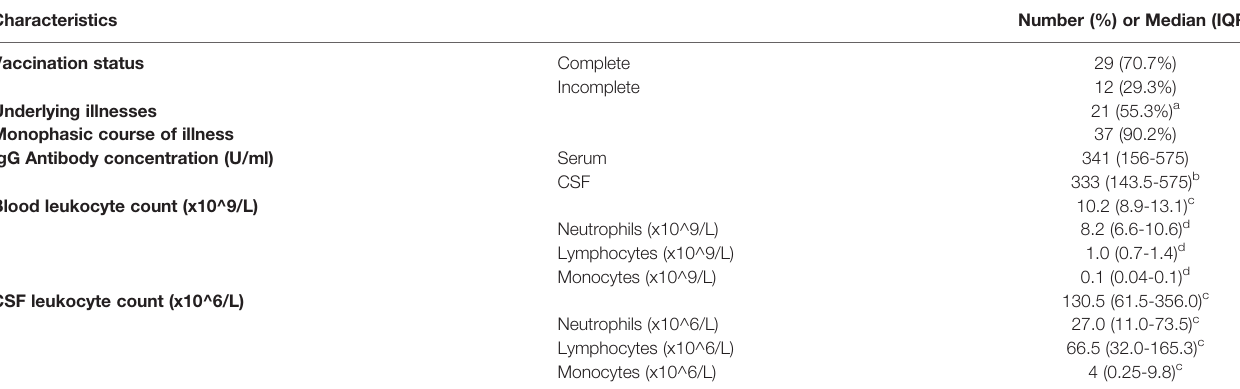
TABLE 1 | Clinical and laboratory data on 41 VBT patients enrolled in the study.